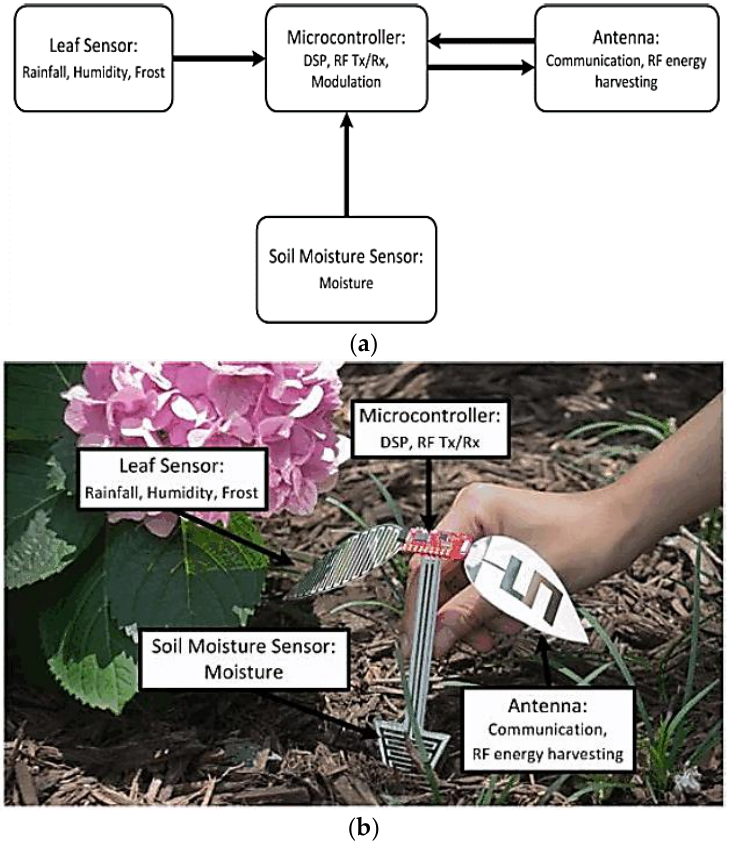
Figure 3. Inkjet-printed sensor platform for agriculture applications: ( a ) block diagram of system; and ( b ) proposed design in operation [49].